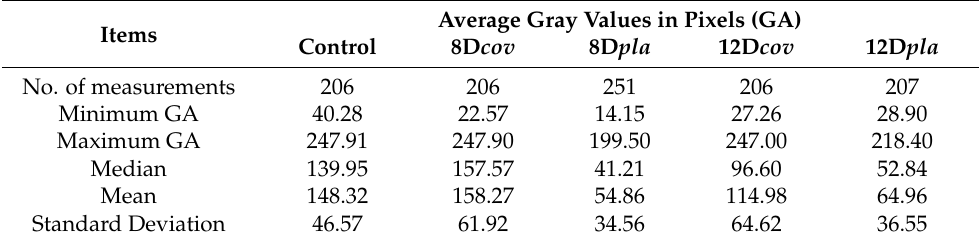
Table 1. Frequency distributions of birefringence average gray values corresponding to optical retardations in sections of rat calcaneal tendons cultivated in vitro.